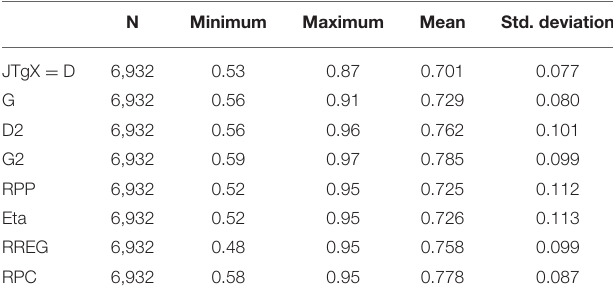
TABLE 5 | Average “population” estimates for the comparison.